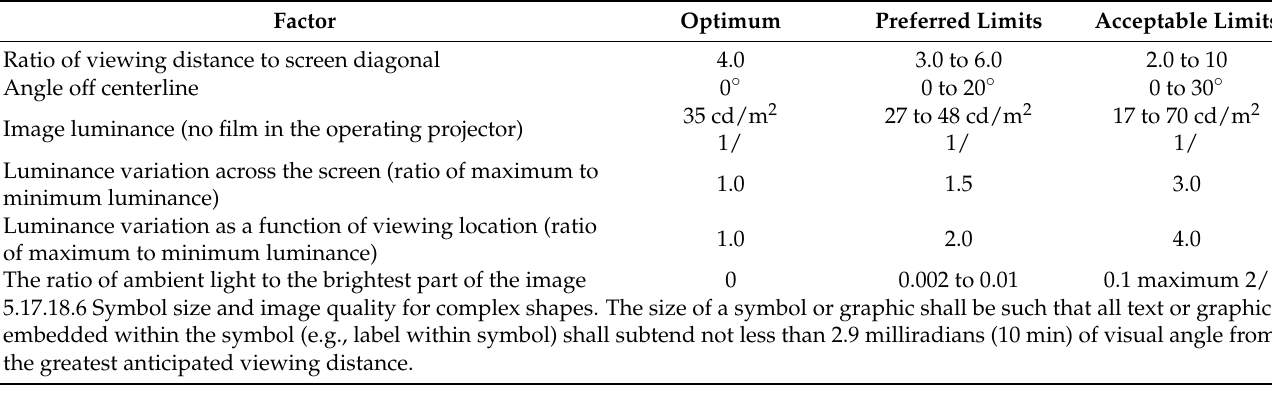
Table 8. Distance based on Wall Screen Size.